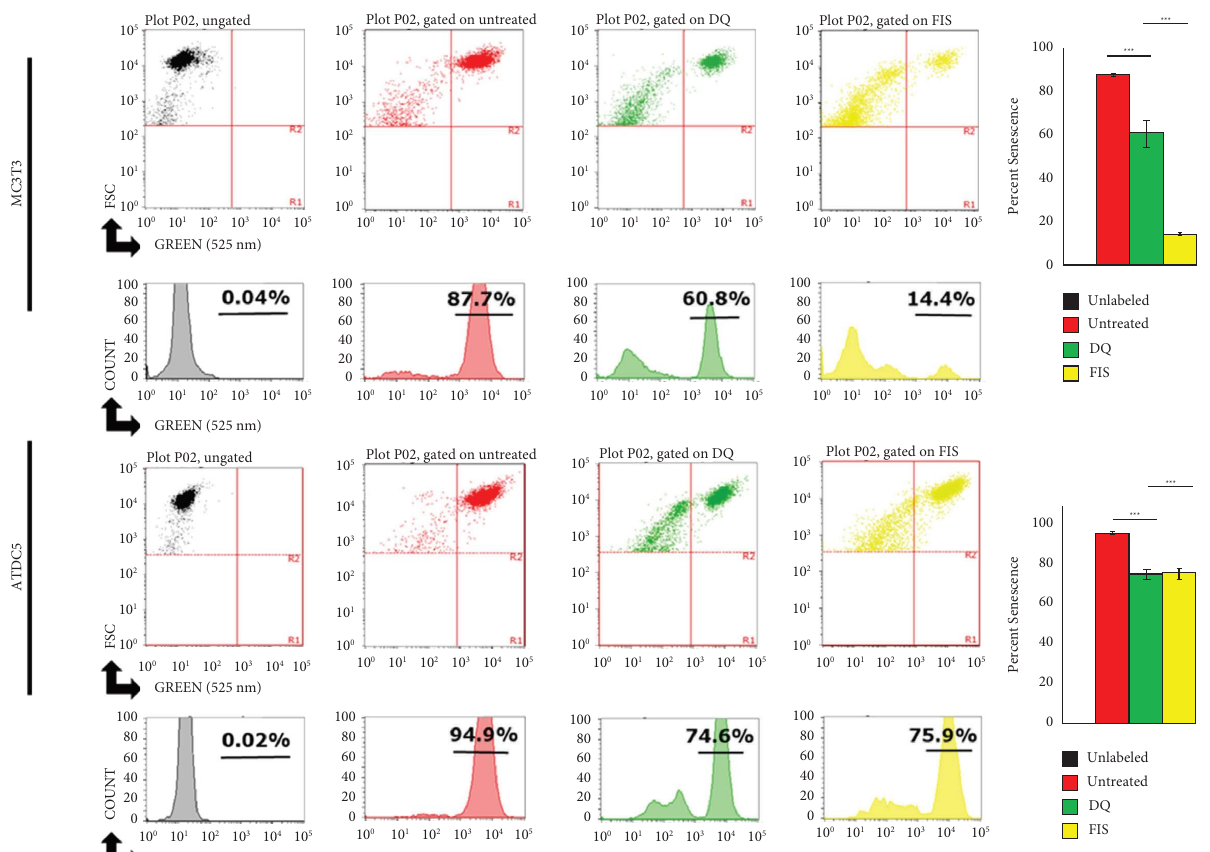
Figure 2: Senolytic drugs reduce senescent cell number in MC3T3 osteoblasts and ATDC5 chondrocytes. Representative fow cytometry plots indicating gating strategy for MC3T3 and ATDC5 cells stained for 1 h with the forescent senescence marker C 12 FDG following treatment with either DQ (200 nM +20 μ M) or FIS (50 μ M) for 48h. Unstained plots represent cells not exposed to C 12 FDG used to exclude debris. Histograms indicating shift in % senescent cell population in cells treated with D +Q or FIS. Quantifcation refects multiple experiments from passage ( ∼ 8) per cell type with 3 wells per treatment, ∗∗∗ P ≤ 0 .